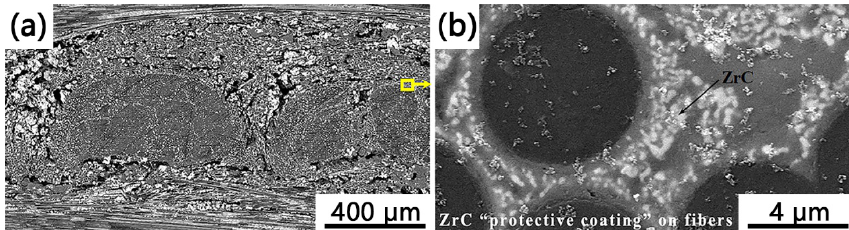
Fig. 23 Microstructure of the nano-porous C f /ZrC–C preforms, with a ZrC “protective coating” formed surrounding the carbon fibers: low magnification of C f /ZrC–C preform (a) and ZrC “protective coating” surrounding carbon fibers (b). Reproduced with permission from Ref. [209], © The American Ceramic Society